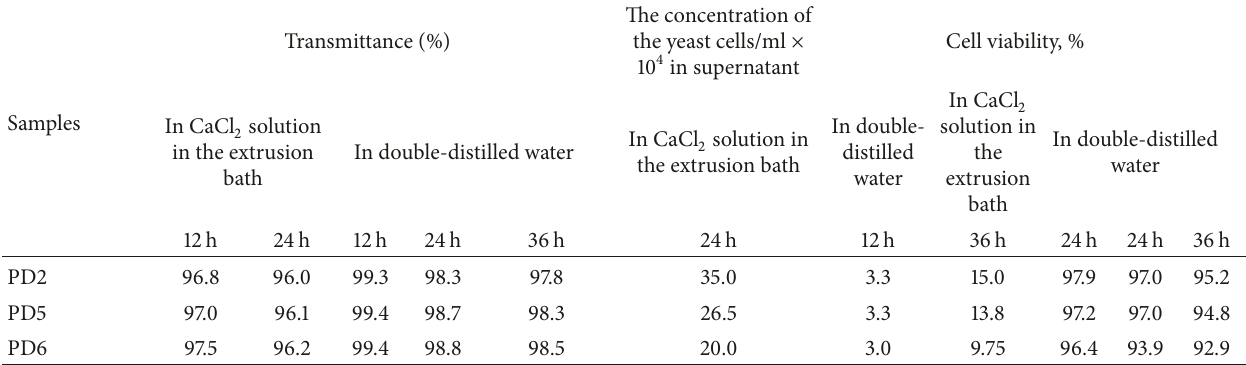
Table 4: Influence of the CaCl 2 concentrations from the cross-linking bath on the stability of the obtained particles with immobilized yeast cells.